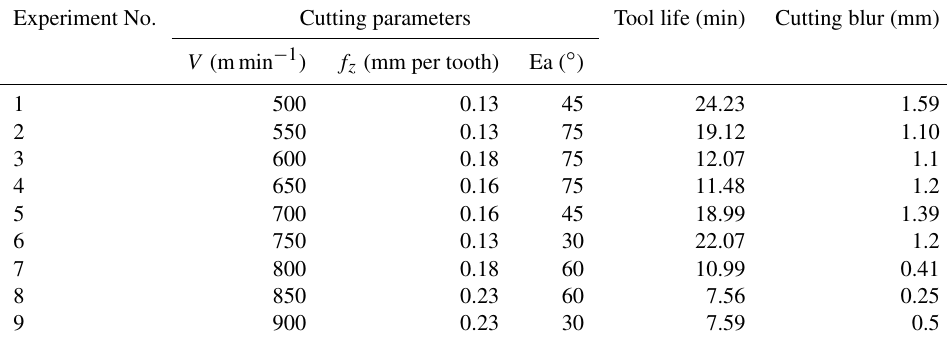
Table 4. Experimental data set used for testing. Experiment No. Cutting parameters Tool life